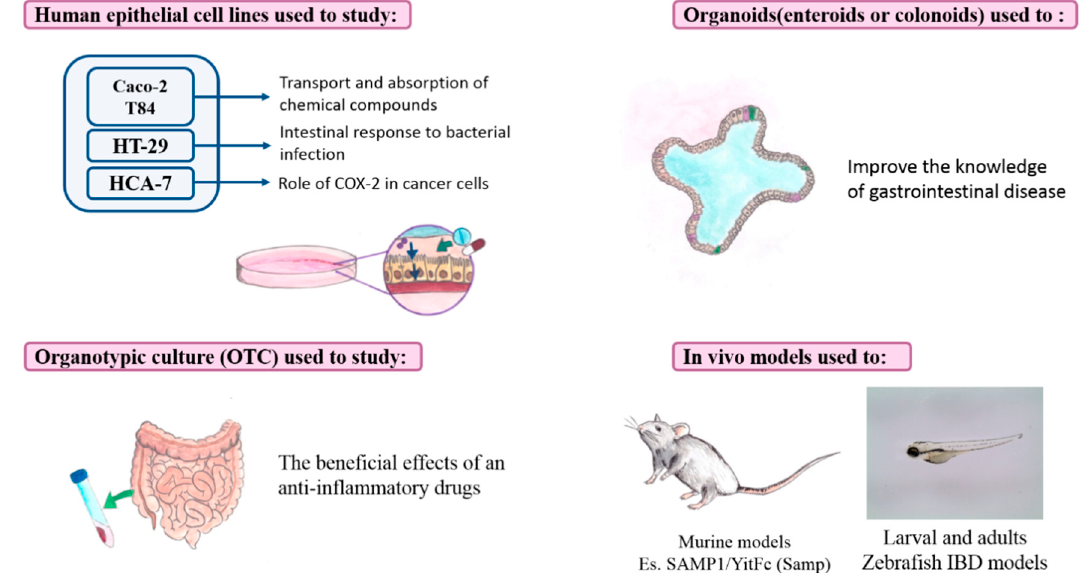
Figure 3. Traditional and innovative in vitro and in vivo models of inflammatory bowel diseases (IBDs). The human epithelial cell lines principally used include: Caco-2, T-84, Ht-29, and HCA-7. They allow one to investigate the function of epithelial barrier in terms of transport and absorption of chemical compounds, and defense mechanisms against bacterial infections. Furthermore, the inflammatory responses in cancer cells may be evaluated. Organotypic culture gives some advantages in pharmacological studies, while organoids offer a more complete representation of intestinal structures with its three-dimensional characteristics. Among the in vivo models, mice are the most used and IBD-like inflammation can be easily induced by means of the exposition to chemical compounds, or using transgenic lines. Future directions may include the use of larval and adult zebrafish, which represent a useful alternative since the costs of management are lower and they allow an easier genetic manipulation and application of imaging techniques.